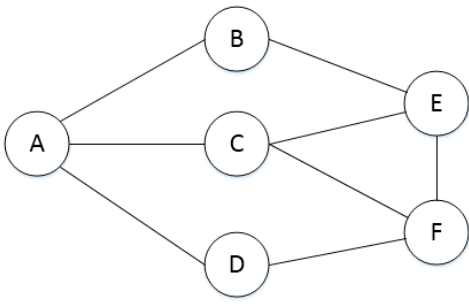
Figure 2. Protein interaction network. Table 1. Adjacency matrix.